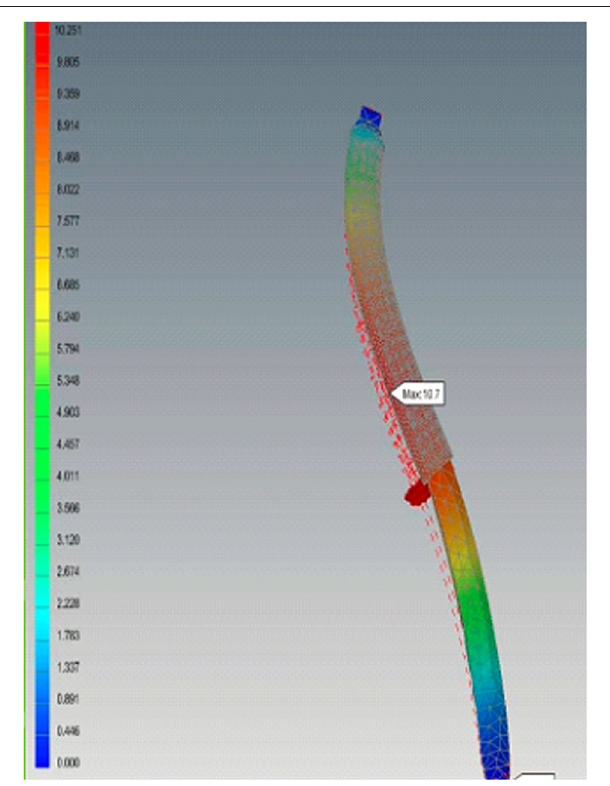
FIGURE 4 | Finite element analysis. A comparison of the stresses predicted and the load location suggest that the results could be in the same range.